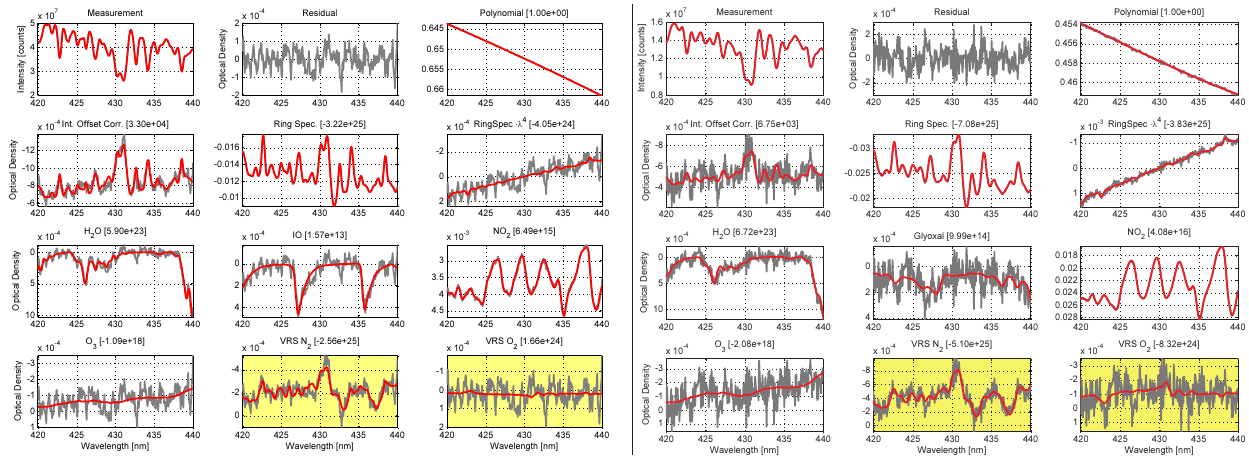
Figure 5. (left) Fit showing the detection of structures from vibrational Raman scattering of N 2 for a spectrum recorded during M91. The main peak at 430nm originates from the reciprocal of a Fraunhofer structure at this wavelength from the Taylor expansion of the optical thickness. It vanishes when orthogonalizing the spectrum with the stray light compensation spectrum 1 /I 0 . The two minima to at 432 and 436nm are the red-shifted calcium Fraunhofer lines. The grey lines are measured quantities, the red line is the modelled OD. The spectrum was recorded on 15 December 2012, starting at 17:38UTC, at 12 ◦ 33 (cid:48) S, 76 ◦ 50 (cid:48) W at a SZA of 14 ◦ and a relative solar azimuth angle (SAA) of 132 ◦ . The FRS spectrum was recorded at 40 ◦ elevation. 16 elevation sequences were co-added, resulting in a time resolution of 2h and a total exposure time of 16min per co-added spectrum. The Fraunhofer reference spectrum was omitted for clarity. Column densities are given in moleccm − 2 . The unit of the measurement spectrum and the intensity offset correction is given in counts. (right) Detection of structures from vibrational Raman scattering on N 2 in data from MAD-CAT. The spectrum was recorded on 15 June 2013, starting at 13:32 UTC, in Mainz, Germany at a SZA of 27 ◦ and a relative SAA of 122 ◦ . The FRS spectrum was recorded at 90 ◦ elevation. Eight elevation sequences were co-added, resulting in a time resolution of 1.5h and a total exposure time of 8 minutes.